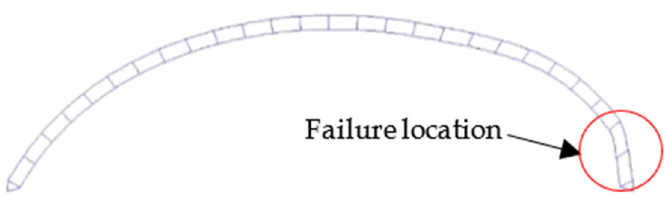
Figure 22. Global deformation of combined chord and connecting plate failure.